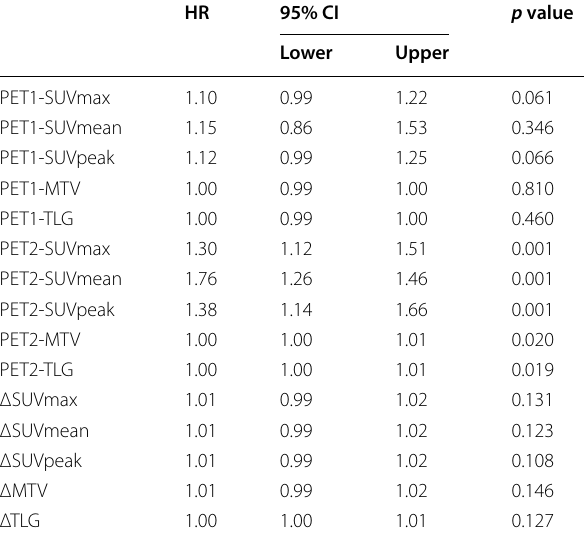
Table 3 [ 18 F]FDG PET parameters and TTP. Univariate